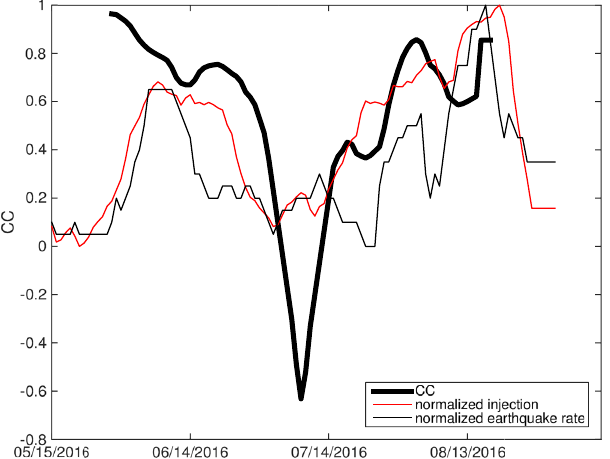
Figure 7. Sliding time window cross correlation (thick black line) between injection (red) and seismicity rate (black) from matched filter detection during the four months prior to mainshock. Both injection rates and seismicity rates are smoothed by 10 days, and the sliding time window is 30 days. A similar figure with 30 days smoothing and 60 days sliding window is shown in Figure S9, which shows more stable correlation. This uses the matched-filter completed catalog for higher temporal